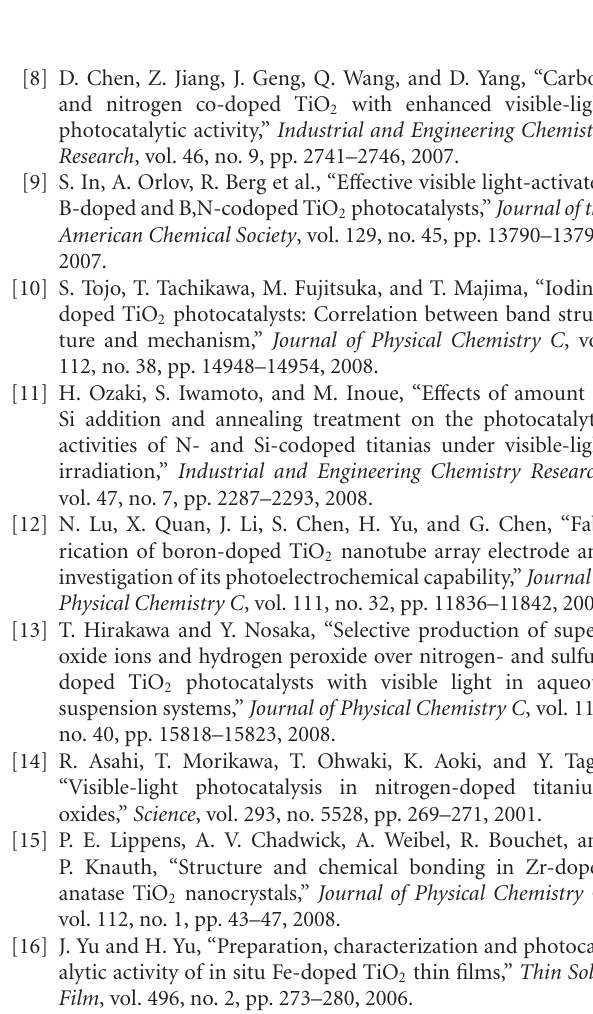
Figure 7: (a) The dependence of ln( C 0 /C ) on the UV illumination time of Fe-doped TiO 2 and (b) the absorption spectra of MO aqueous solution at di ff erent time span of UV light